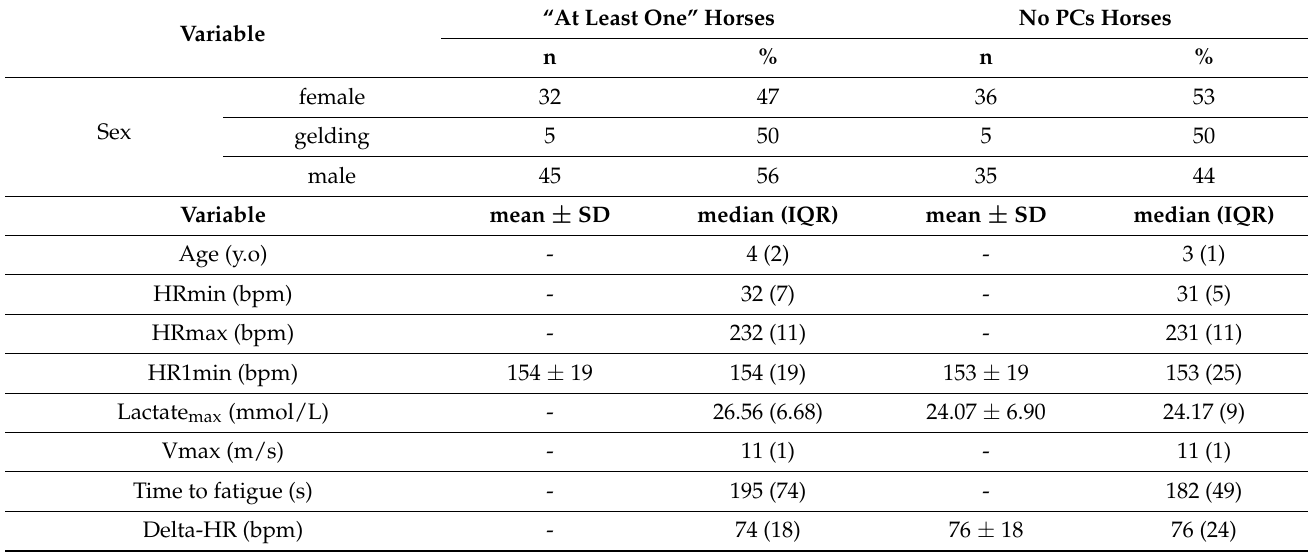
Table 3. Demographic, cardiac, and performance data of horses grouped according to the “at least one”